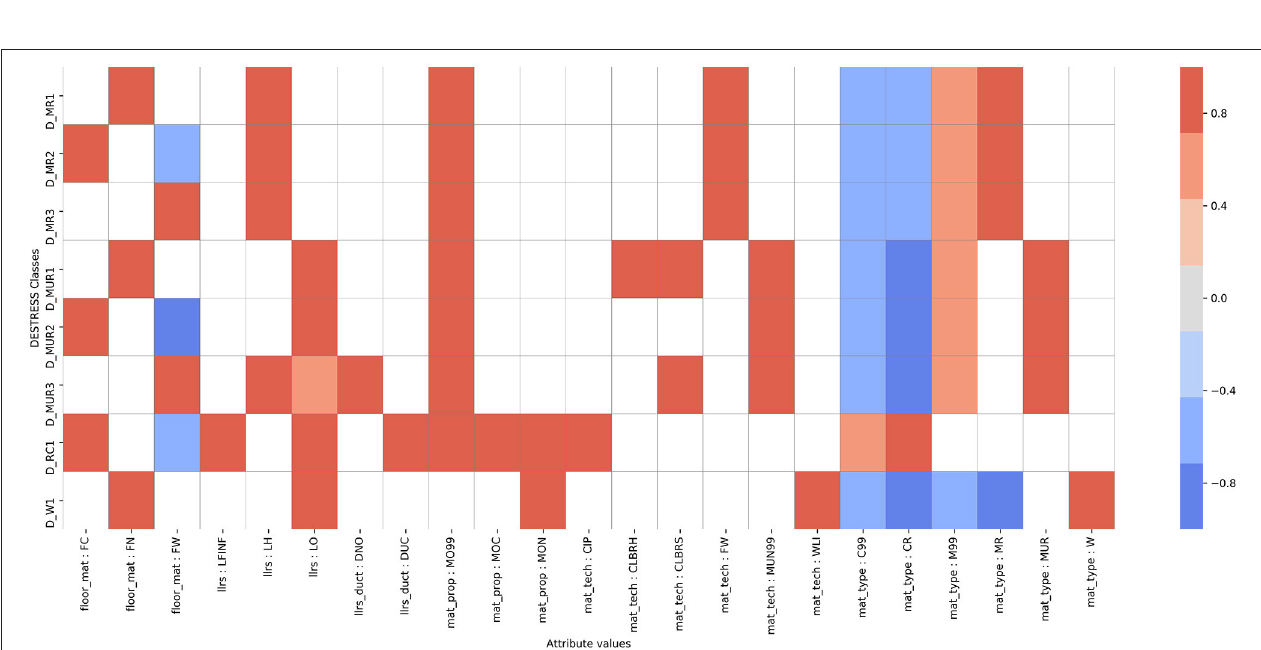
Frontiers in Built Environment |